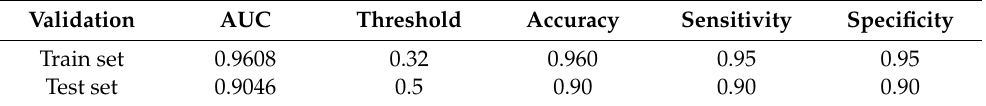
Table 2. The accuracy and AUC of IntegralVac’s predictions. The AUC and accuracy values were greater than those of the control methods but remained lower than the AUC/accuracy of the refer- enced methods, such as DeepVacPred and MHCSeqNet. This may be because IntegralVac increased the coverage and complexity of the dataset and used multiple sources for our peptide data, thus affecting sensitivity and specificity values and lowering